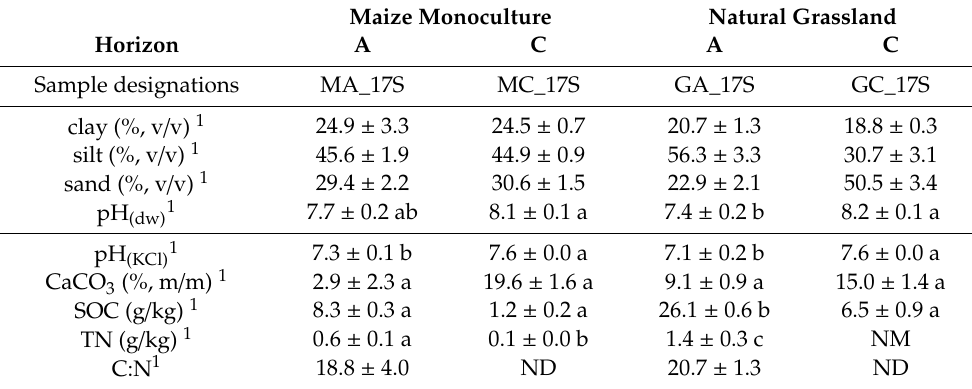
Table 1. Physical chemical properties of the studied topsoil and parent materials. Maize Monoculture Natural Grassland Horizon A C A